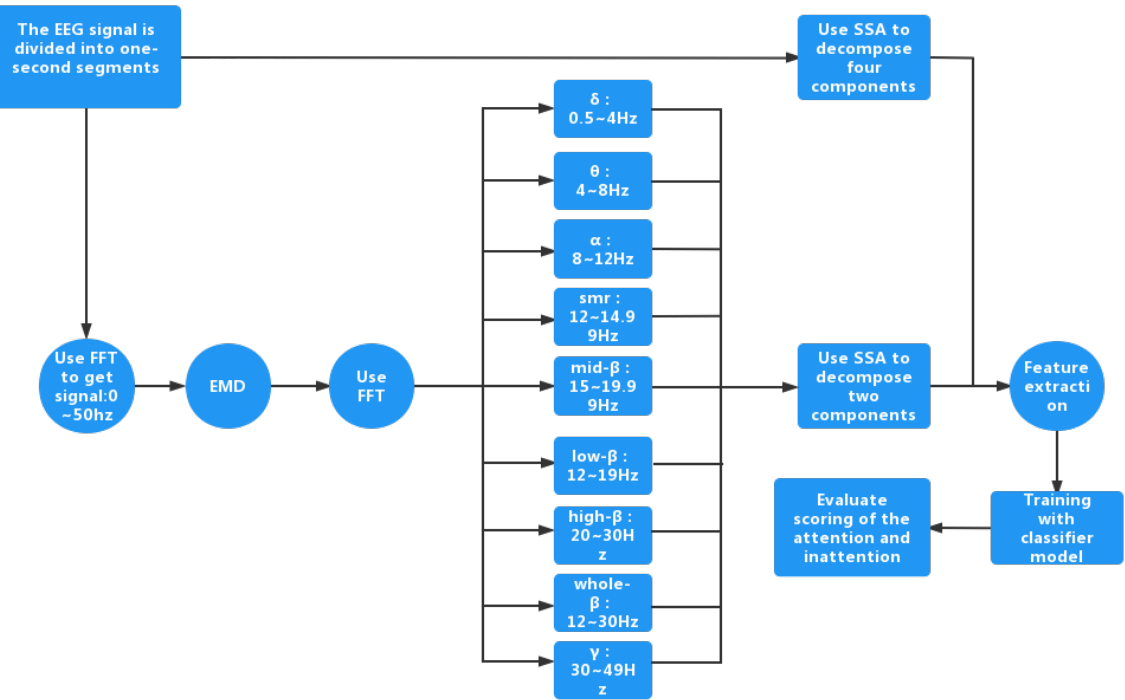
Figure 2. The block diagram of our proposed method.